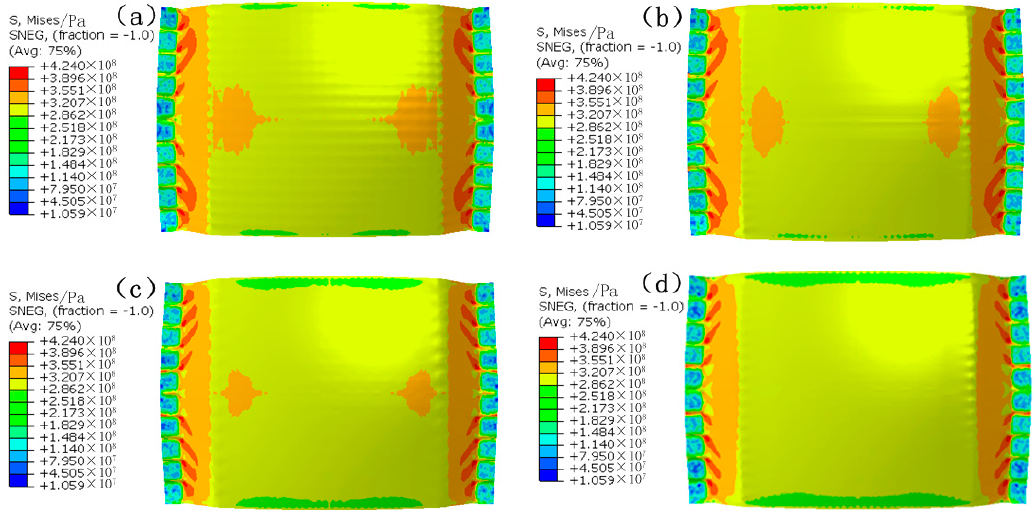
Figure 7. Stress distribution of the formed parts: ( a ) formed by FBHC; ( b ) formed by SBHC; ( c ) formed by SBHDS; ( d ) formed by SBHPS.